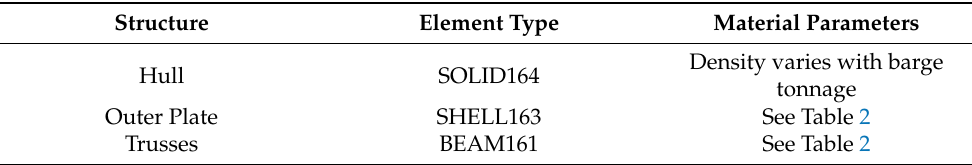
Table 5. Element types and material parameters of barge